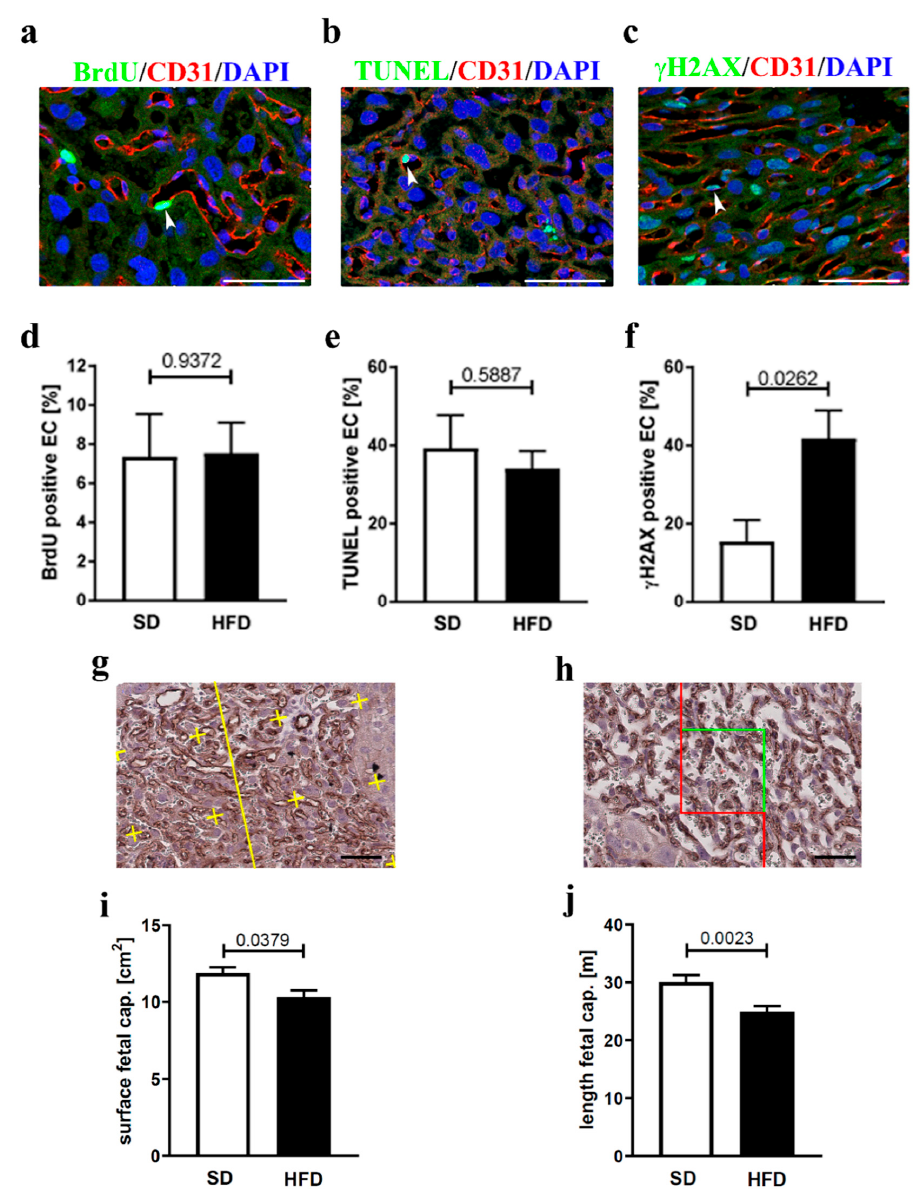
Figure 2. E ff ect of HFD on placental endothelial cell homeostasis and vessel structure. ( a ) Representative image of an IF co-staining of the placental lz from controls (SD) with BrdU (green), CD31 (red), and 4 ′ ,6-diamidino-2-phenylindole (DAPI) (blue). A BrdU-positive CD31-positive cell is marked with an arrow. Scale bar 50 µm. ( b ) Same as ( a ), but TUNEL (green), CD31 (red), and DAPI (blue) co-staining. ( c ) Same as ( a ), but with gammaH2AX (green), CD31 (red), and DAPI (blue) co-staining. ( d – f ) Quantification of either BrdU ( n = 6 placentas, one placenta per dam, for both SD and HFD), TUNEL, or gammaH2AX ( n = 7 placentas, one per dam, for both SD and HFD) positive endothelial cells (EC) in the lz of placentas from either control (SD) or obese (HFD) dams. The p -value is indicated in the graph. ( g ) Representative image of the lz of a control (SD) placenta, stained with an antibody against CD31. Lines and crosses (yellow) are necessary to assess the surface of fetal capillaries (CD31-positive vessels). Scale bar 50 µm. ( h ) Same as ( g ), but with rectangles (green and red lines) to assess length of fetal capillaries. ( i ) Quantitative analysis of fetal capillary surface [cm 2 ] in the placental lz of SD ( n = 8 placentas from eight dams) and HFD ( n = 7 placentas from seven dams) mice. The p -value is indicated in the graph. ( j ) Quantitative analysis of fetal capillary length [m] in the placental lz of SD ( n = 8 placentas from eight dams) and HFD ( n = 7 placentas from seven dams) mice. The p -value is indicated in the